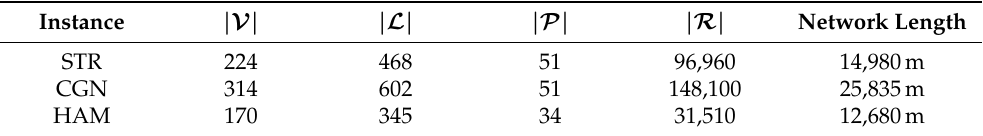
Table 3. Overview of the large instances’